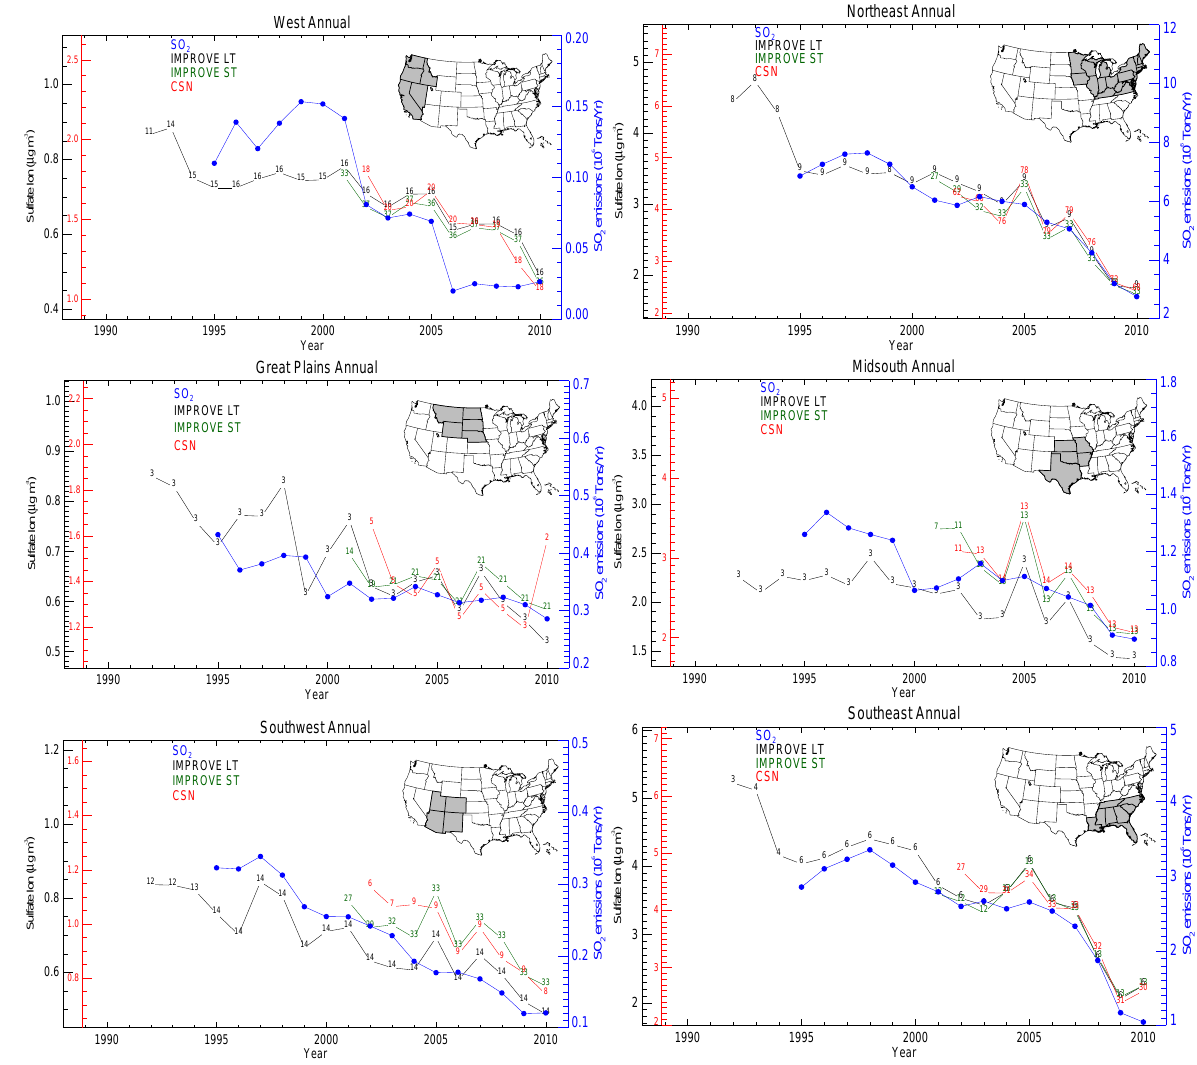
Fig. 7. Regional annual mean particulate sulfate ion concentrations (µg m − 3 ) from long-term (LT) and short-term (ST) IMPROVE sites (left black axis) and CSN sites (left red axis), and power plant SO 2 emissions (million tons yr − 1 ) (right blue axis) for (a) West (b) Northeast (c) Great Plains (d) Midsouth (e) Southwest (f) Southeast. The inset maps show the states in the region in gray. The number of complete sites with valid data available for a given year is used as the plot symbol for each time